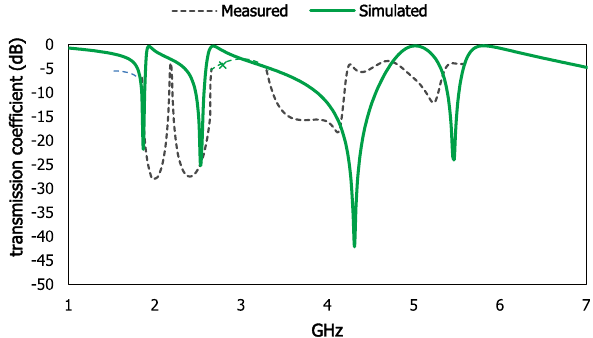
Figure 12. Simulated and measured result of the proposed